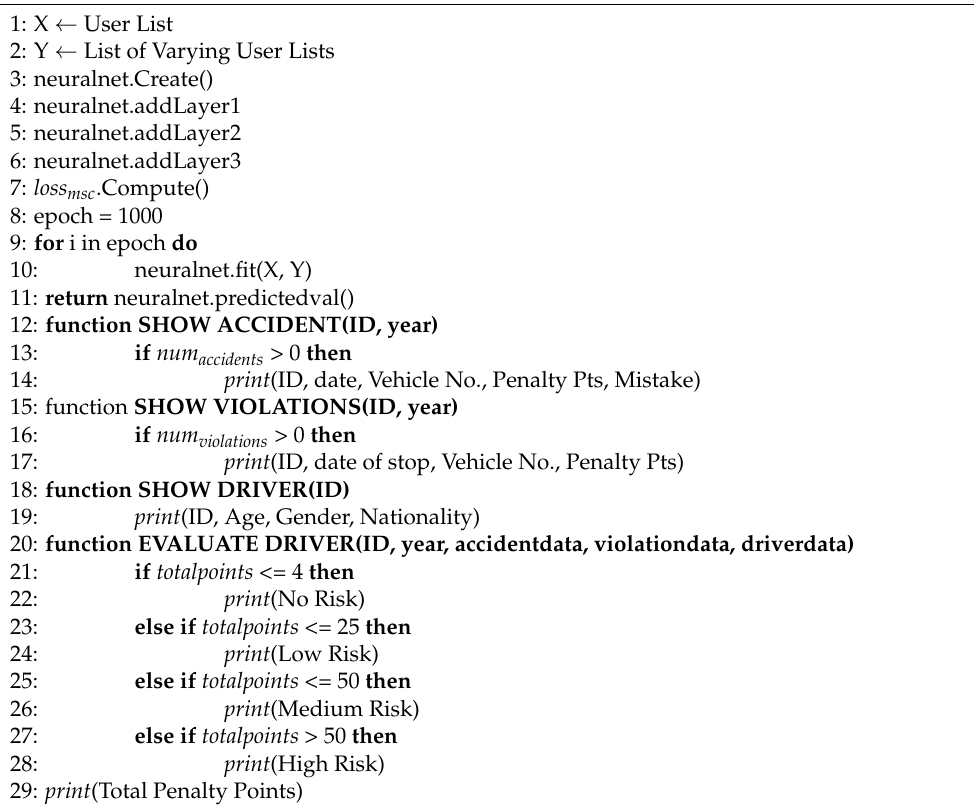
Algorithm 1 Driver Accident/Violation Classification System